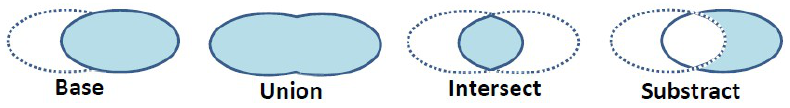
Figure 4. Examples of Boolean operations.